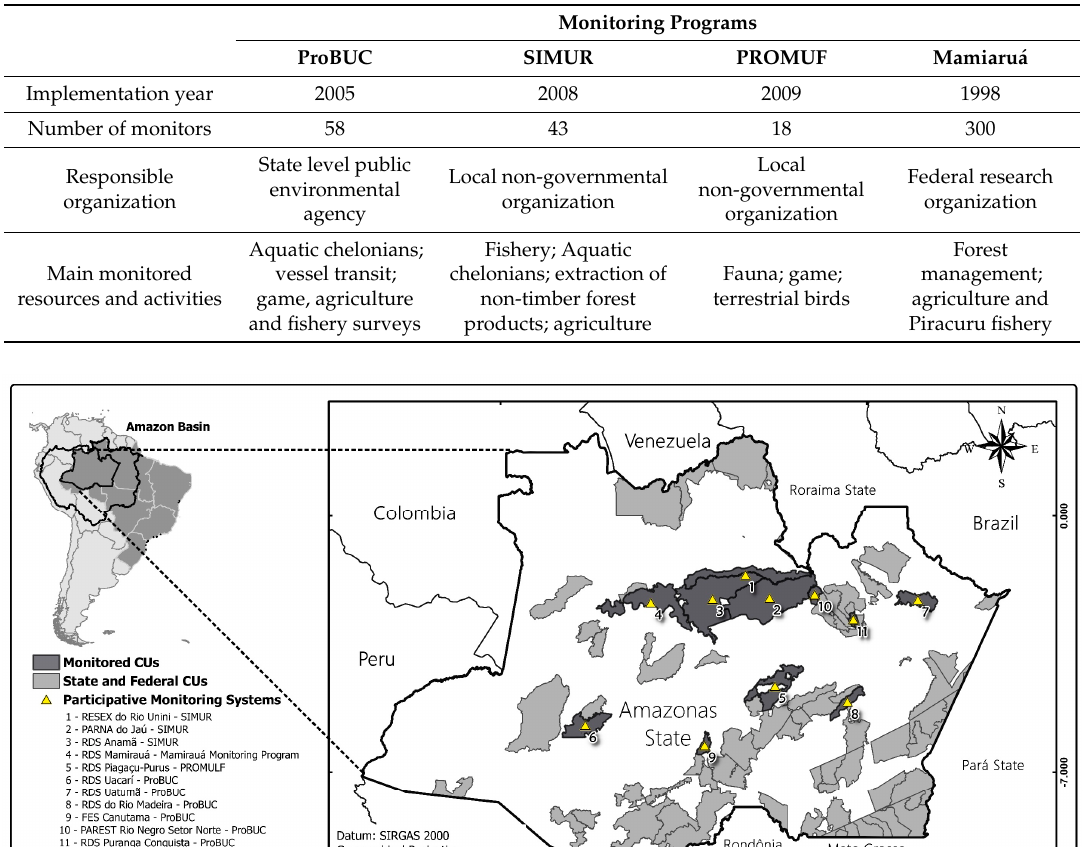
Main characteristics of four participatory community monitoring (PCM) programs implemented in Amazonas State, Brazil.